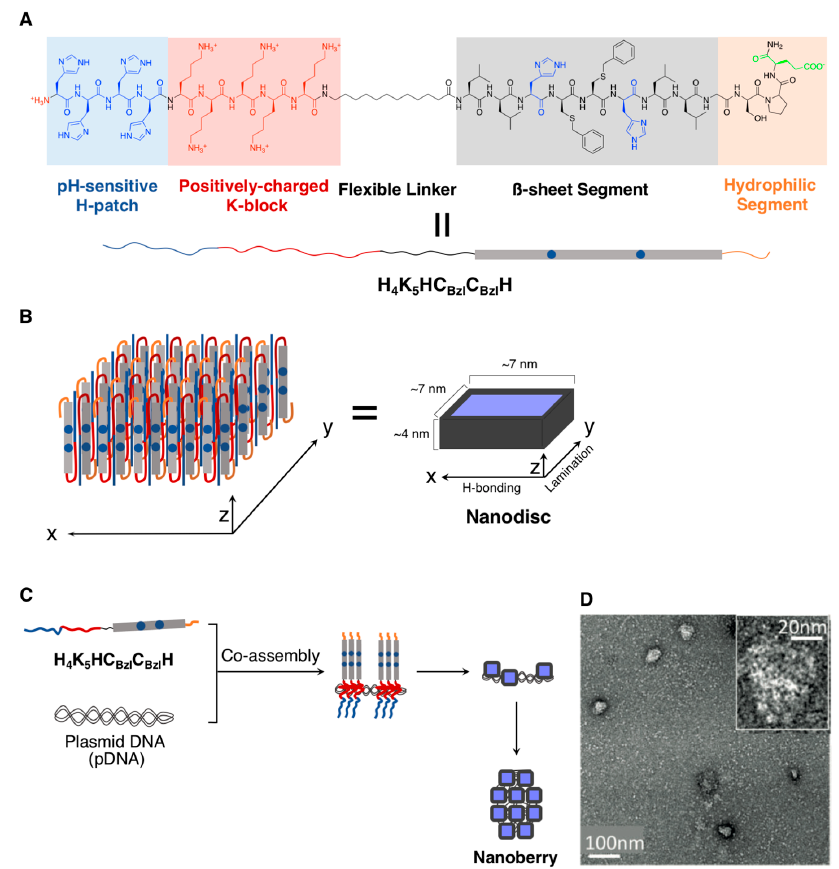
Figure 3. ( A ) Chemical structure of the self-assembling peptide derivative, H 4 K 5 HC Bzl C Bzl H . ( B )